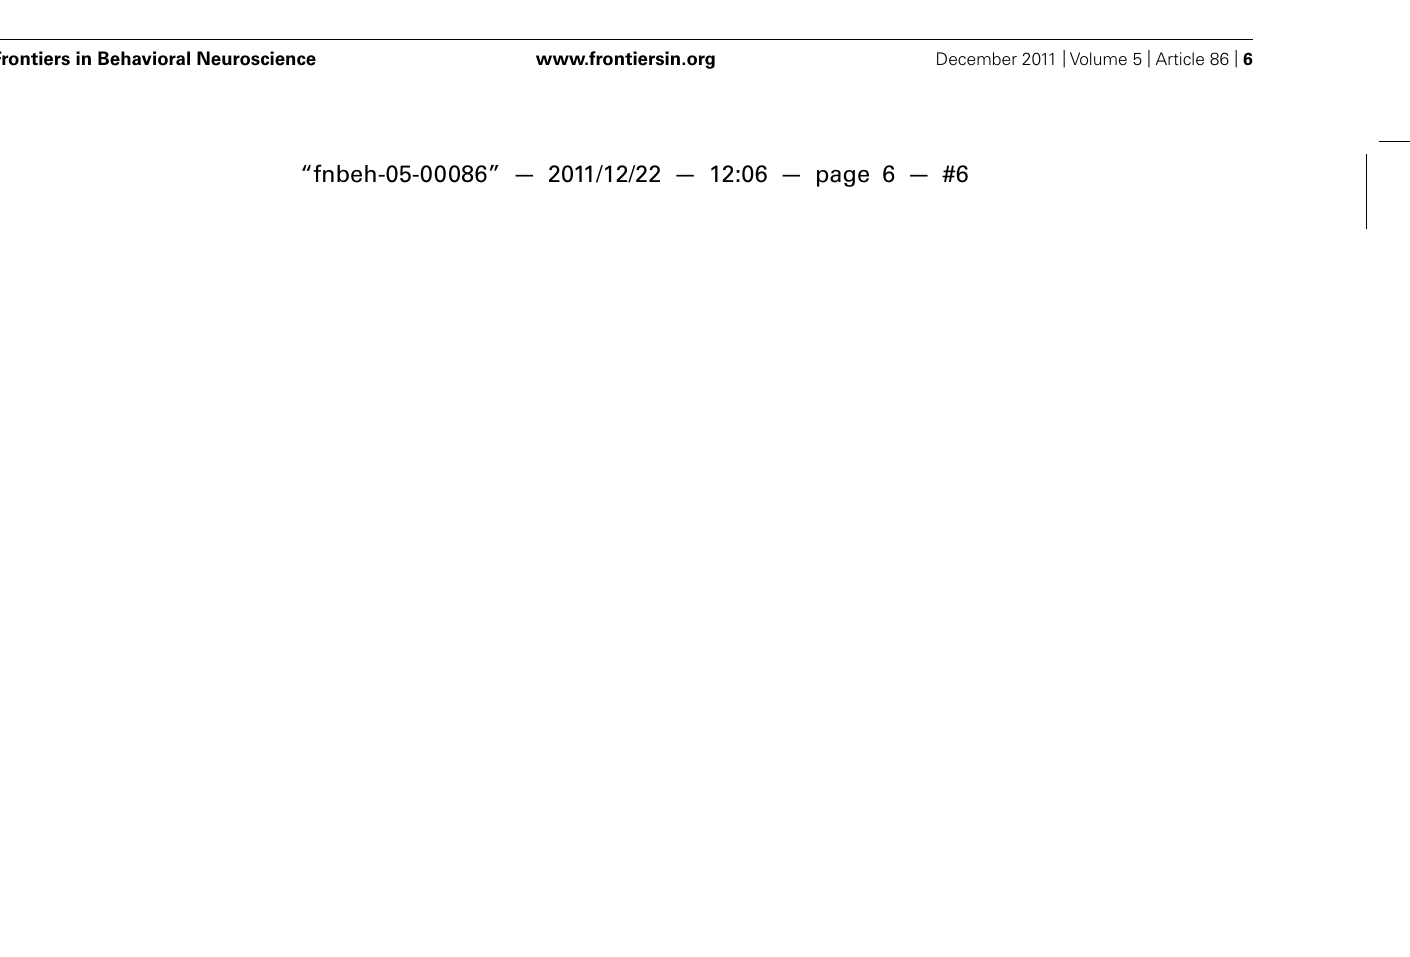
FIGURE 4 | (A) Step-through latency (median and inter-quartile range) as a function of foot-shock intensity (0.35 vs 0.7 mA) measured 1 week post- training (* vs all, p < 0.01); (B) Step-through latency (median and inter-quartile range) as a function of Rolipram dose (0, 3, and 10 mg/kg) injected